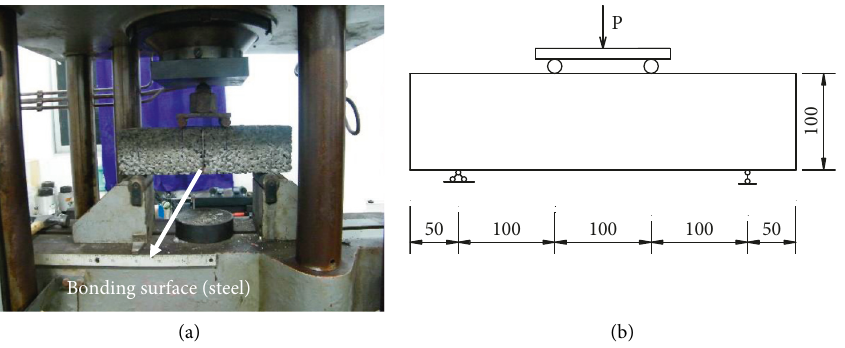
Figure 6: Test device and loading diagram for the flexural test (unit: mm). (a) Test device. (b) Loading diagram. Table 3: Results of the pull-off tests of polymer-modified cement lattice concrete-steel deck interfaces formed by different interface binders. Type of